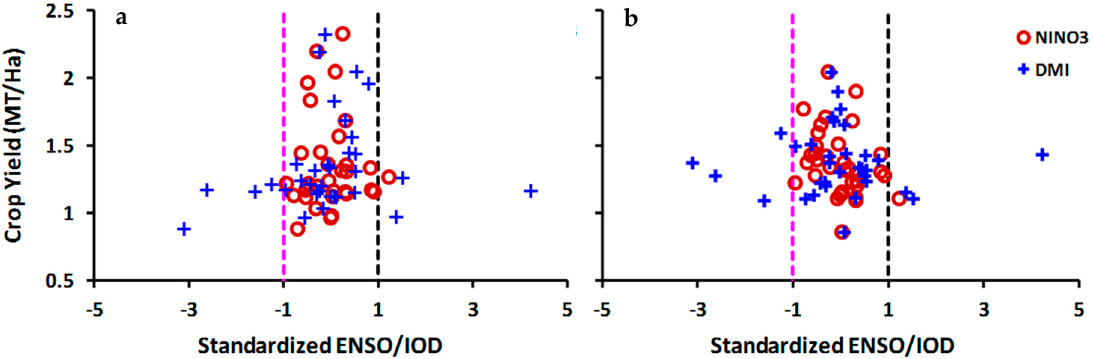
Figure 19. Crop yield in metric ton per hectare (MT/ha) as a function of climate modes in ( a ) Ethiopia and ( b ) Tanzania for 1982–2014. Note that the climate modes are annual averages from their respective standardized monthly indices.